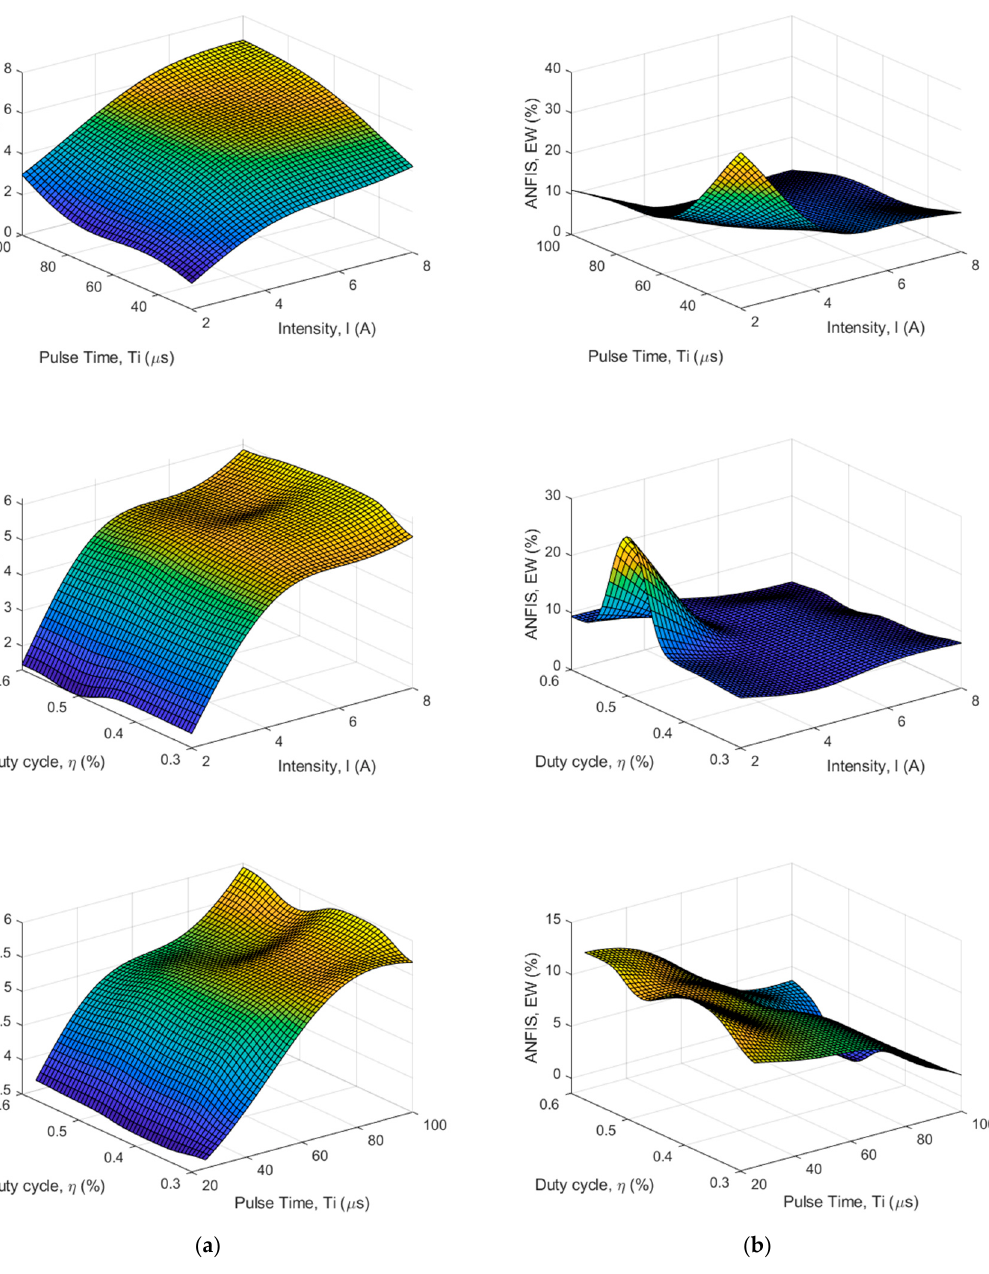
Figure 1. ( a ) Surface roughness average, Ra (µm), as a function of (Intensity, Pulse Time and duty cycle) (type 1 function) and ( b ) Electrode Wear, EW (%), as a function of (Intensity, Pulse Time and duty cycle) (type 2 function). Surface responses have been generated using an ANFIS from experimental data taken of Ref. [61].